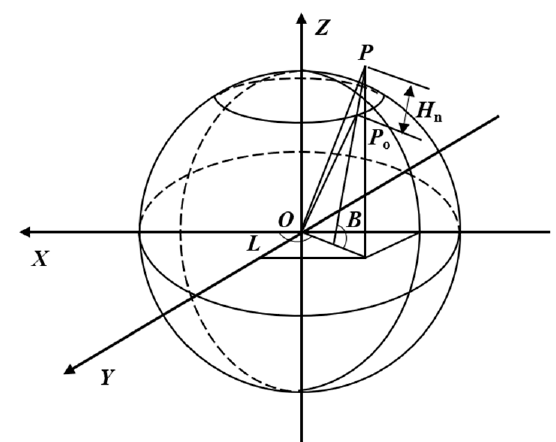
Figure 2. Geodetic coordinate system to the rectangular coordinate system. The radius of curvature N can be solved by Equations (2) and (3):